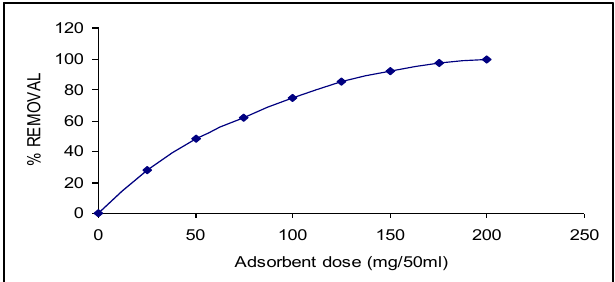
Figure 3. Relationship between adsorbent dose (mg/50 ml) and % removal of chromium (VI).